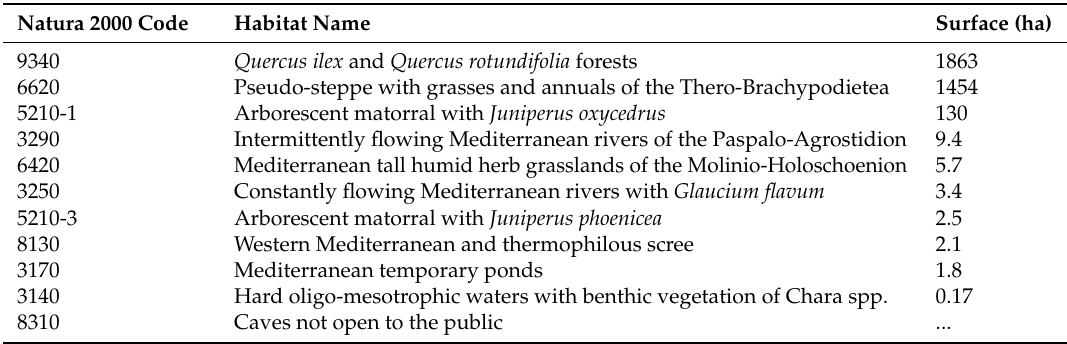
Figure 1. ( a ) Study area with color infrared (CIR) airborne image and ( b ) examples of vegetation structures with CIR airborne image, NDVI airborne and Pléiades images, and Pléiades panchromatic image with (1) dense cover of low ligneous (LL) ( Quercus coccifera ); two structure types of highly mix of herbs (H) and LL with (2) early stage of encroachment by LL dominated by Quercus coccifera and (3) LL dominated by Juniperus oxycedrus . Radiometric dynamic is indicated by the greyscales for NDVI images and Pléiades panchromatic band. Table 2. List of the habitats of community interest that are present in Montagne de la Moure et Causse d’Aumelas site